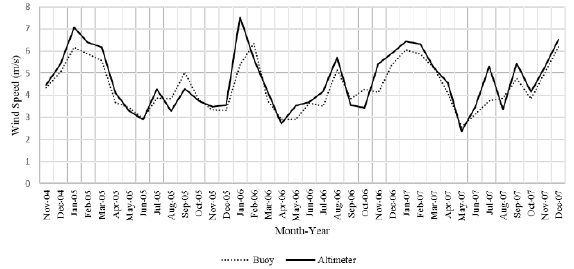
Figure 4. Time-series graph of inter-comparison altimeter and buoy for point located at Sabah Sea for monthly